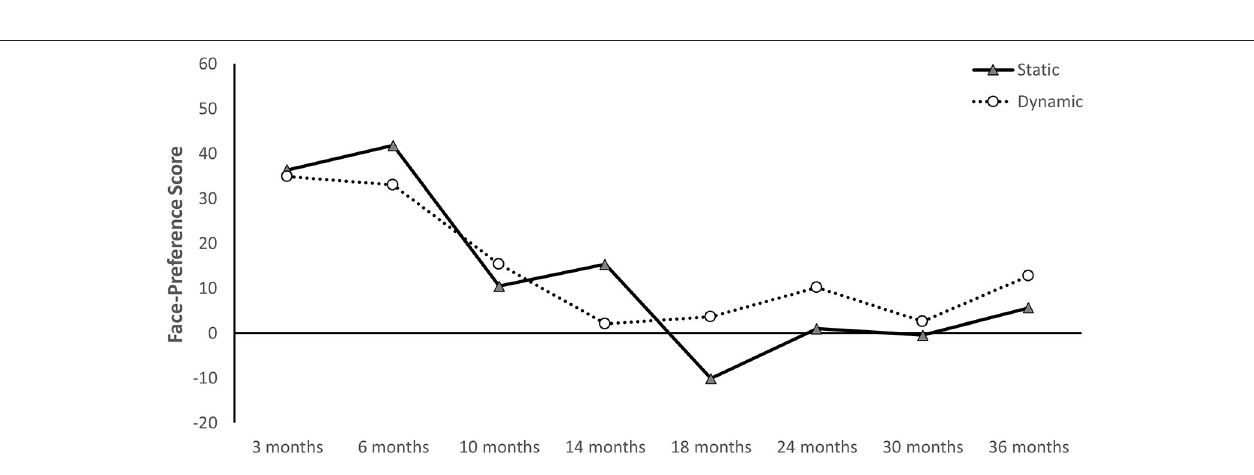
FIGURE 5 | Longitudinal face-preference scores averaged across 10 data